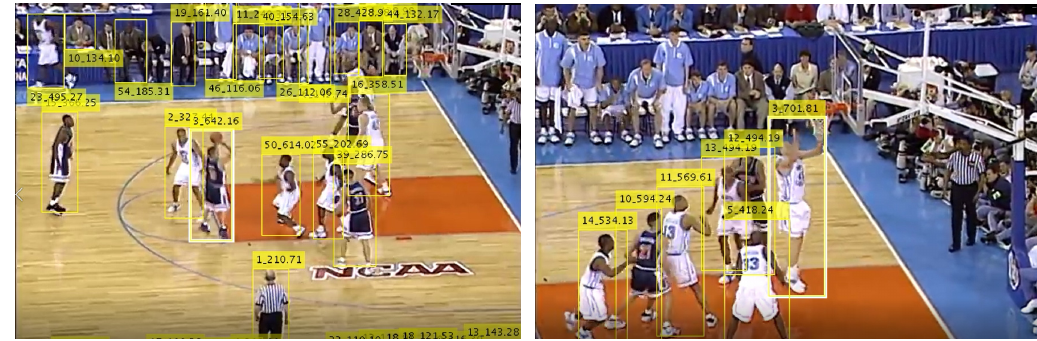
Figure 22. Marking of the leading player in basketball scenes (white thick bounding box).